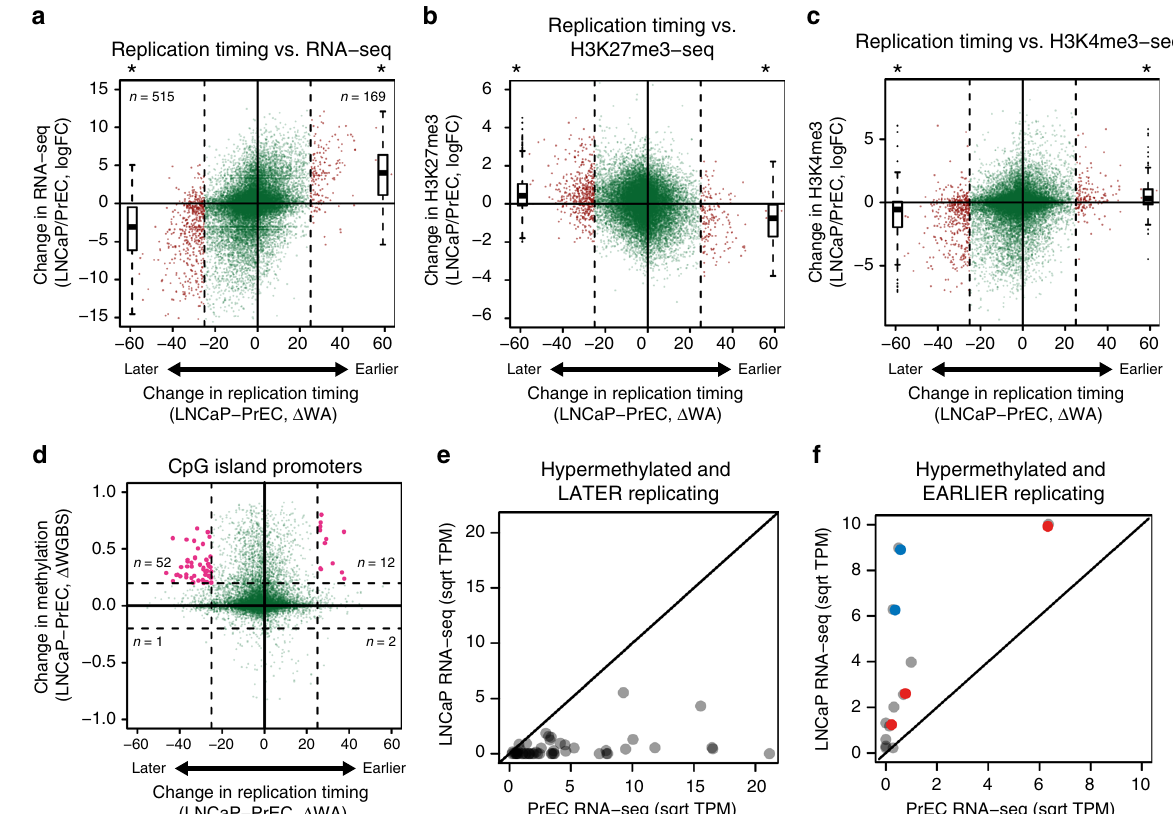
Fig. 3 Relationship between replication timing, DNA methylation and expression. a Difference in replication timing ( Δ WA) compared to the change in gene expression (log fold change, logFC). b , c Scatterplots showing the relationship between change in replication timing and change in H3K27me3 and H3K4me3 read density between PrEC and LNCaP at gene promoters. In a – c , dashed lines indicate a | Δ WA| > 25, outside of which indicates a change in replication timing (red points). logFC boxplots for later or earlier genes are on the left and the right of the scatterplot, respectively. Later or earlier genes are signi fi cantly changed in expression compared to genes between | Δ WA| > 25 (asterisk, Student ’ s T -test, p < 2.2e − 16). d Difference in replication timing compared to change in methylation at CpG-island promoters. Vertical dashed lines indicate a | Δ WA| > 25 (LNCaP-PrEC) and horizontal dashed lines indicate a | Δ WGBS| > 0.2 (LNCaP-PrEC). Promoters that are hypermethylated and either later or earlier are coloured in pink. e Comparison of expression levels (square root mean.TPM) between PrEC and LNCaP for hypermethylated and later gene promoters. f Comparison of expression levels (square root mean.TPM) between PrEC and LNCaP for hypermethylated and earlier gene promoters. Solid diagonal line indicates equal expression between PrEC